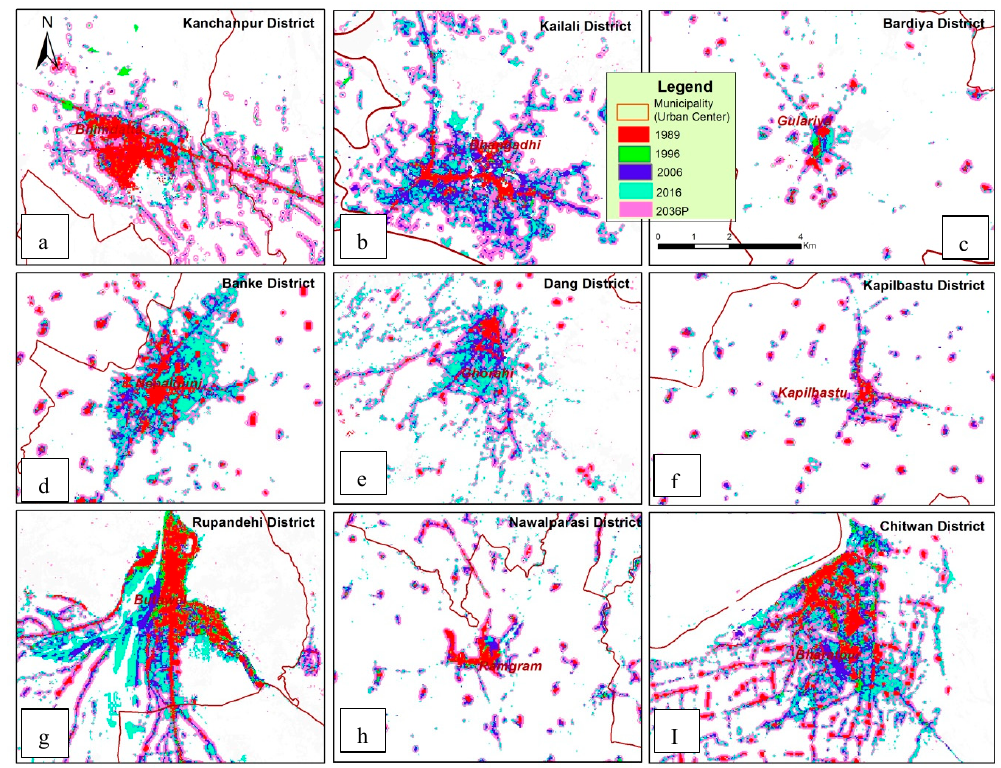
Figure 3. Urban extend by year, historically (1989, 1996, 2006, 2016) and in 2036 (projected (P)), in selected urban centers in the Tarai region: ( a ) Bhimdatta municipality, ( b ) Dhangadhi sub-metropolitan city, ( c ) Gulariya municipality, ( d ) Nepalgunj sub-metropolitan city, ( e ) Ghorahi sub-metropolitan city, ( f ) Kapilbastu municipality, ( g ) Butwal sub-metropolitan city, ( h ) Ramgram municipality, ( i ) Bharatpur metropolitan city. Statistics of LULC over time are provided as Supplementary Materials (Table S2).